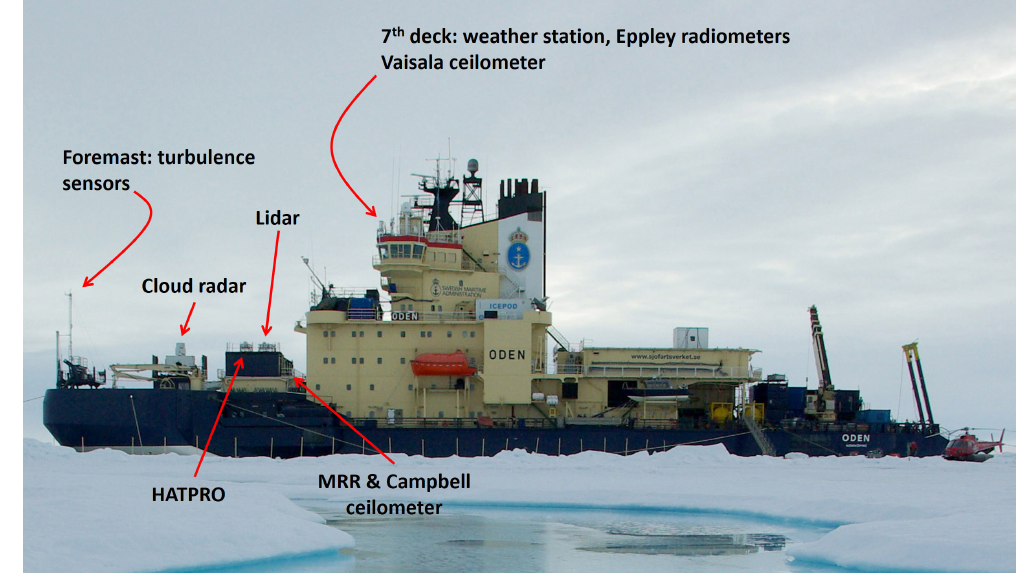
Figure 2. Picture of the icebreaker Oden and the location of the instruments.